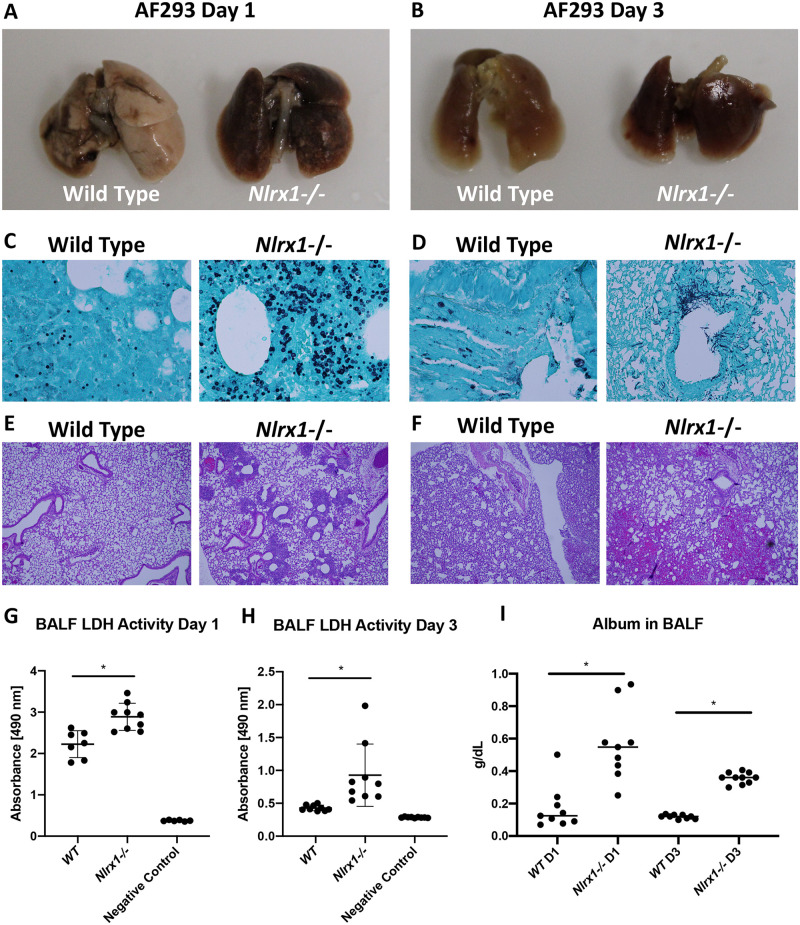
Characterization of pulmonary inflammation and fungal burden on day 1 and 3 post inoculation with AF293.Freshly harvested conidia from the AF293 isolate were delivered via aerosolization (12 mL, 1 X 109 conidia/mL) to immuno-competent wild type and Nlrx1-/- mice. (AB) Gross anatomy of excised lungs perfused with formalin on day 1 and 3 post inoculation. (CD) Grocott’s methenamine silver stain and (EF) hematoxylin and eosin stain of lung sections from wild type and Nlrx1-/- mice on day 1 and 3 post inoculation. (GH) Lactate dehydrogenase activity in bronchoalveolar lavage fluid (BALF) from wild type and Nlrx1-/- mice on day 1 and 3 post inoculation. (I) Albumin levels in BALF from wild type and Nlrx1-/- mice on day 1 and 3 post inoculation. Asterisk denotes statistical significance, P < 0.05, Mann-Whitney U test. Error bars indicate standard deviation. N = 6–10.